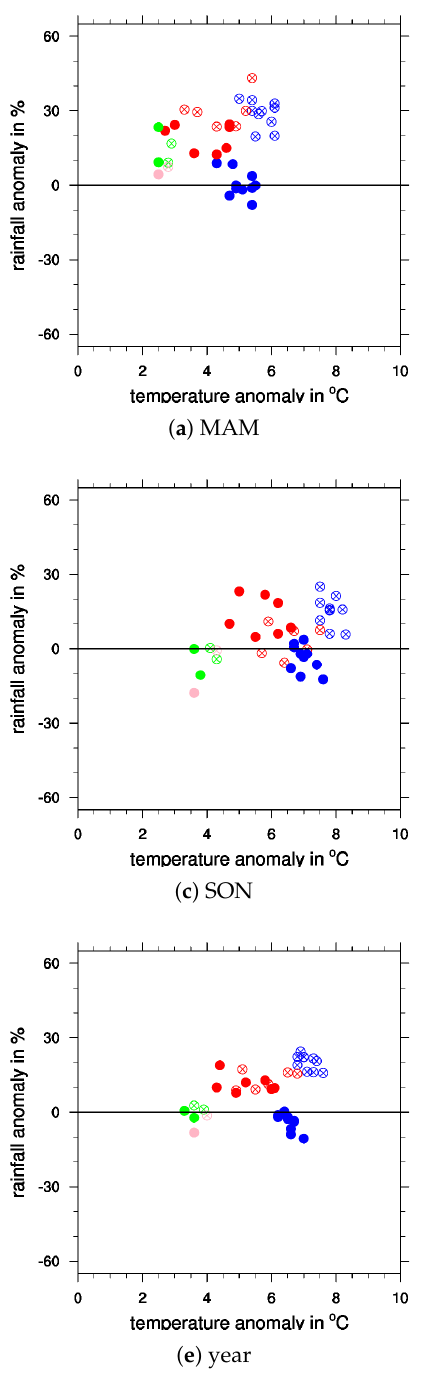
Figure 5. Comparison of the direct GCM output (crossed circles) and EPISODES downscaling results (filled circles) based on SSP5-8.5 (CMIP6) for Germany. The symbols show the Germany-wide mean climate change signal in annual/seasonal precipitation and temperature for 2071–2100 with respect to 1971–2000. Different colours correspond to different GCMs. (Seasons: ( a ) spring (MAM), ( b ) summer (JJA), ( c ) autumn (SON), ( d ) winter (DFJ), and ( e )